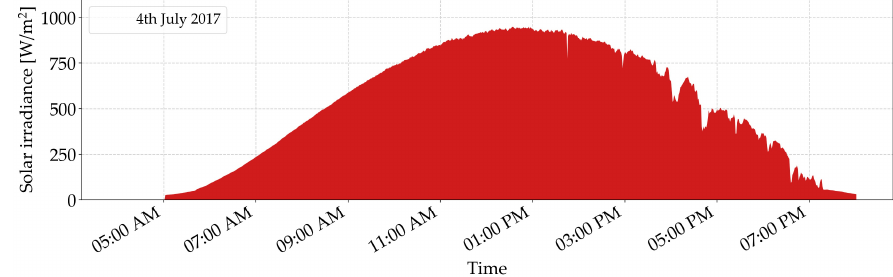
Figure 11. Solar irradiance profile on 4 June 2017. Energies 2020 , 13 , x FOR PEER REVIEW